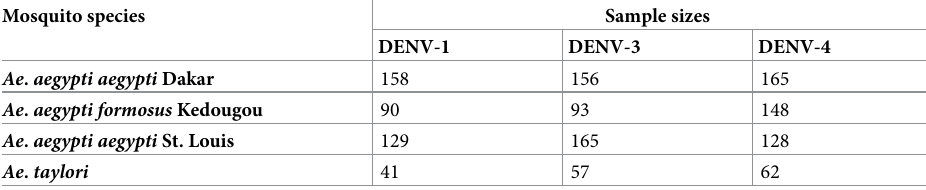
Table 3. Sample size for each virus strain and for each mosquito